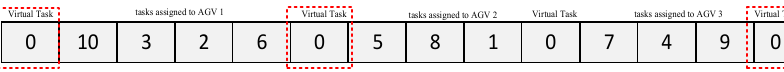
Figure 4. Chromosome diagram of AGV task assignment.